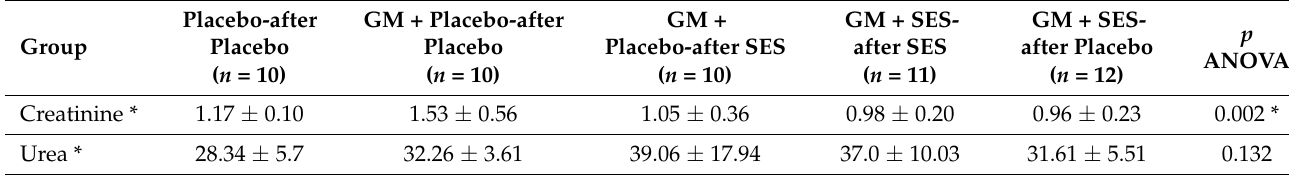
Table 2. Comparison of serum creatinine and urea